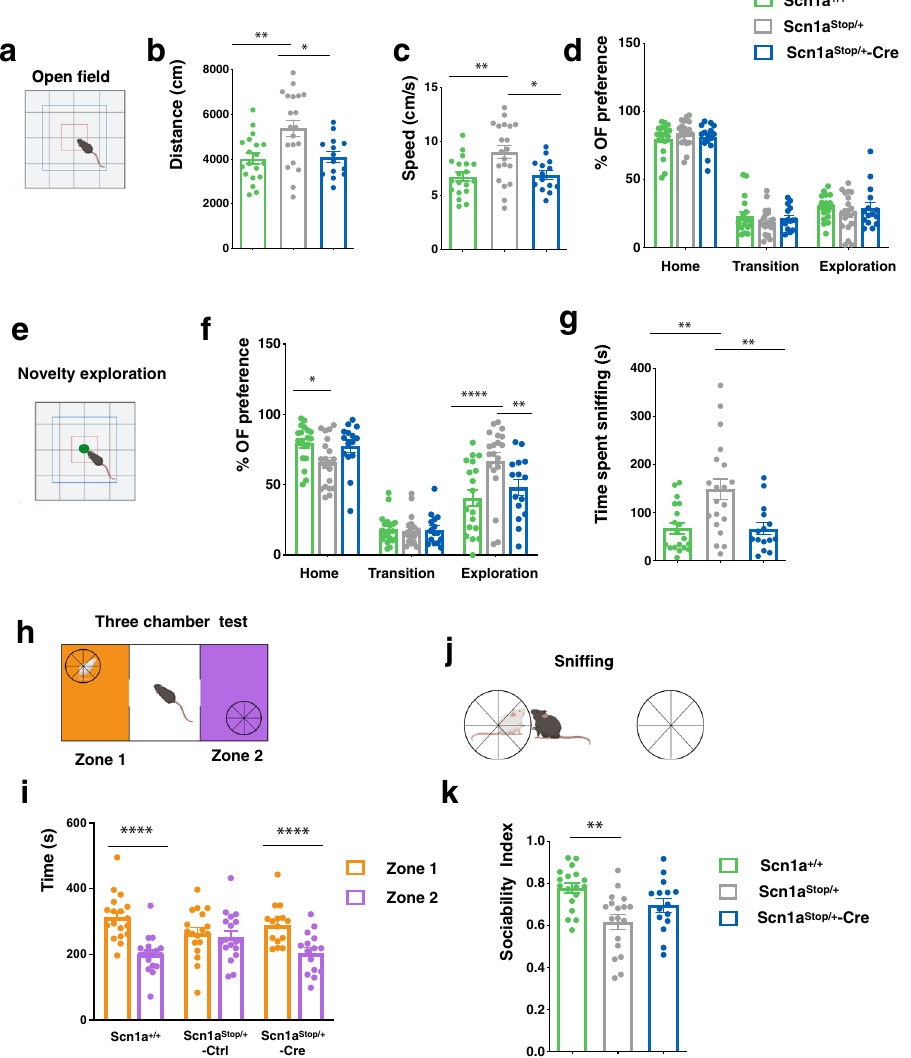
Fig. 4 Re-expression of Scn1a gene after symptom onset rescues altered interactions with environment and social impairment in Dravet mice. a Scheme of the open fi eld arena ( b ) distance traveled (** p = 0.0041, * p = 0.0134, one way-ANOVA followed by Tukey ’ s multiple comparisons). c Velocity (** p = 0.0048, * p = 0.016, one way-ANOVA followed by Tukey ’ s multiple comparisons). d Percentage of time spent in home (two way-ANOVA). e Scheme of the arena with a novel object in the center. f Percentage of time spent in home, transition and exploration areas after that a novel object has been placed in the center of the arena; (* p < 0.05, ** p = 0.006, **** p < 0.0001, two way-ANOVA followed by Tukey ’ s multiple comparisons). g Time spent snif fi ng the novel object (** p < 0.005, one way-ANOVA with Tukey ’ s). n = 19 for Scn1a + / + , n = 20 for Scn1a Stop/ + -Ctrl and n = 15 for Scn1a Stop/ + -Cre for open fi eld test. h Scheme of the three chamber test. i Time spent in zone1 and zone 2 chambers when an unfamiliar mouse is placed in zone 1 chamber (**** p < 0.0001, two-way ANOVA followed by Tukey ’ s multiple comparisons). j Snif fi ng. k Sociability index. (** p = 0.0010, one-way ANOVA followed by Tukey ’ s multiple comparisons). Data are shown as mean ± SEM, with dots representing individual mice, n = 18 for Scn1a + / + , n = 18 for Scn1a Stop/ + -Ctrl and n = 15 for Scn1a Stop/ + -Cre for three-chamber test. Source data are provided as a Source Data fi le. a , e , h, j were Created with hyperactivity, social interaction, working memory and spatial (C57Bl6/N) fi rst at P18-P23, when DS symptom start to develop. reference memory defects. Based on their fi ring pattern, GAD67-GFP + interneurons in patched CA1 (Fig. 6b) were classi fi ed as FS or non-fast spiking (non-FS) and analyzed separately. Both FS and non-FS interneurons recorded in Scn1a Stop/ + mice ring failure . Impairment in excitability and high-frequency show a reduced number of evoked action potentials (AP) at low and fi ring of different subtypes of GABAergic interneurons is a high stimulation intensities, with a shift of input/output curves characteristic of DS mice 13,14,19 – 21 , with a more prominent defect toward higher current step amplitudes (Supplementary Fig. 7b, f). in Parvalbumin + (PV) fast spiking (FS) interneurons 13,14 . To Also maximal fi ring frequency was reduced in Scn1a Stop/ + FS assess if this defect characterizes also our reversible mouse model interneurons with respect to control (Supplementary Fig. 7c), while and drives the characteristic associated phenotype, we performed only a trend is observed in non-FS (Supplementary Fig. 7g). whole-cell patch clamp analysis on acute brain slices of Scn1a Stop/ Current threshold, de fi ned as the minimal current injection able to + (129 Sv) mice crossed with Gad67-GFP knock-in mice 22 elicit neuronal fi ring, was increased in both interneuron subtypes